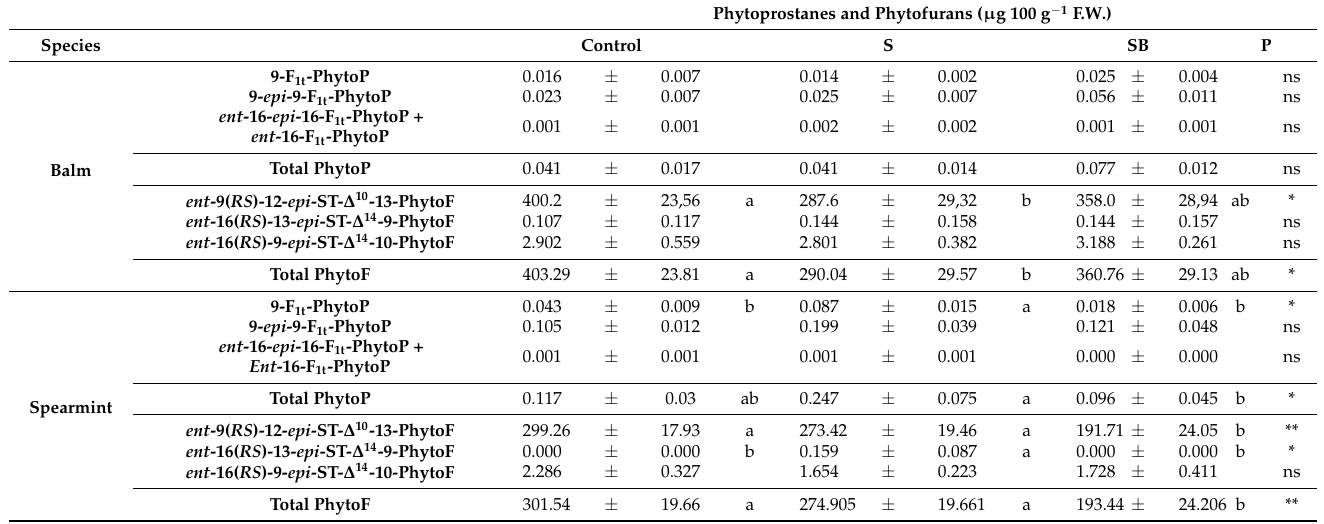
Table 5. Concentration of phytoprostanes and phytofurans in leaves of balm and spearmint plants irrigated with water from different sources at 15th day. Values are mean ± S.E. of six